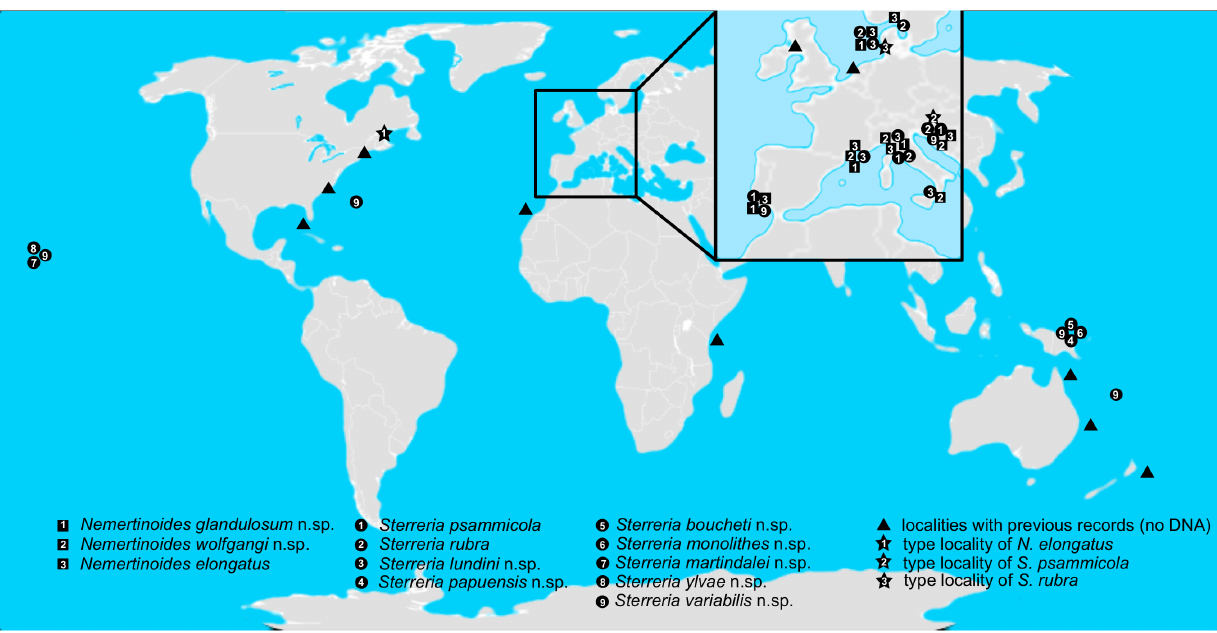
Figure 5. Distribution map. World map showing the distribution of all named species of Nemertodermatida in this study, Europe is shown in an expanded view. Records for presence of Nemertinoides species are shown as squares, Sterreria species as dots with numbers corresponding to the species (see legend within Figure). Localities with records for ‘‘filiform’’ Nemertodermatida from the literature are marked as triangles and type localities of the previously described species are shown as stars.